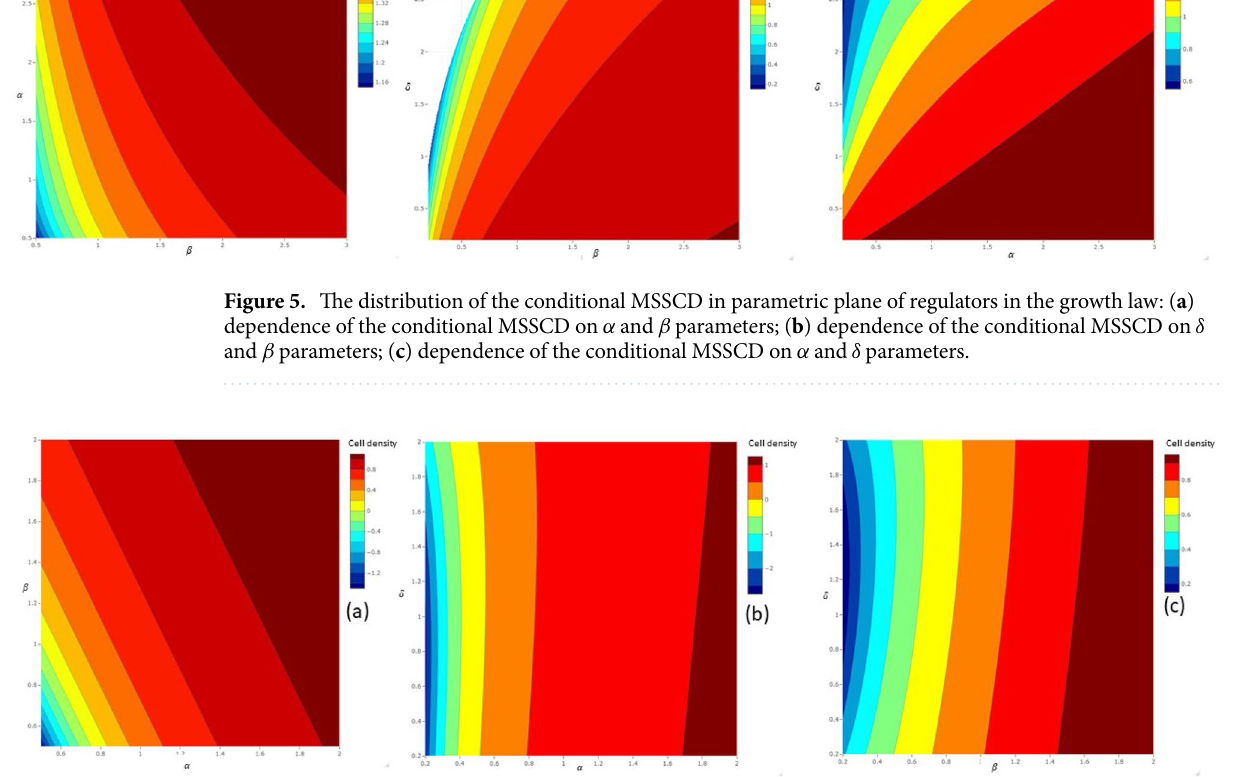
Figure 6. The distribution of cell density at maximum RPR in parametric plane of regulators in the growth law: ( a ) dependence on α and β parameters; ( b ) dependence on α and δ parameters; ( c ) dependence on δ and β